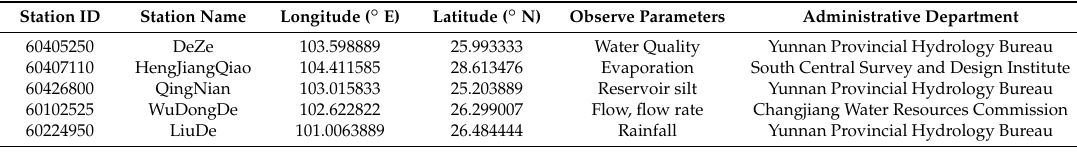
Table 2. List of the hydrometeorological stations in the lower reaches of the Jinsha River Basin used in this study.